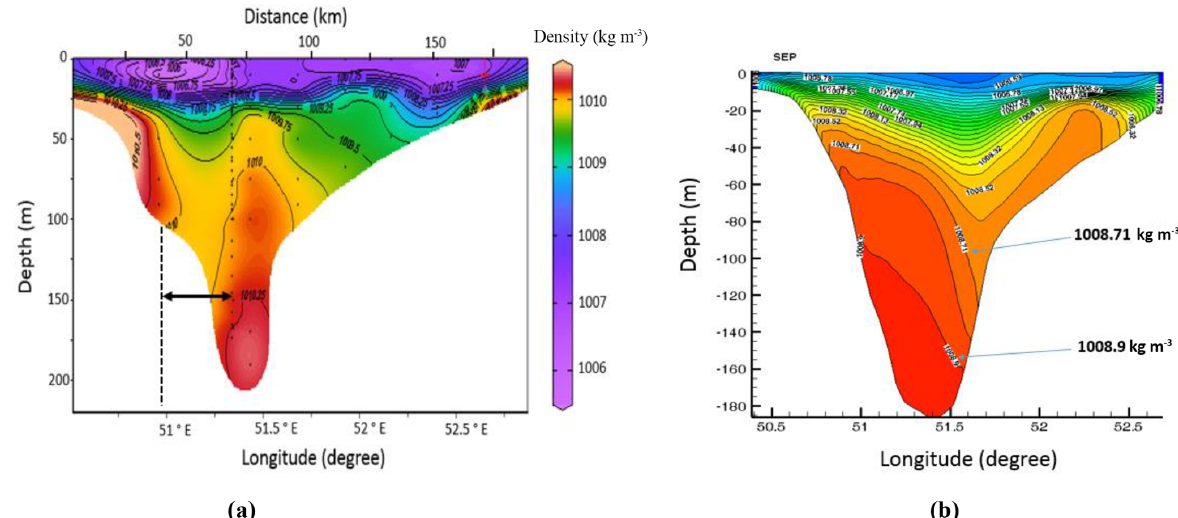
Figure 4. Comparison between density fields across the strait in transect I, in September from observational data (a) and from the numerical model (b) . For observational data, dots show the locations of measurements. For a better understanding of the spacing of the CTD stations, the distance is plotted in kilometers on the top of Fig. 4a. The cross sections are about the same, but the differences between the two transects near the bottom, particularly in the west of the strait, are mainly due to the low resolution of observational data (a) . The numerical transect clearly shows the boundary trapped overflow for which two isopycnals near the bottom are highlighted (b)